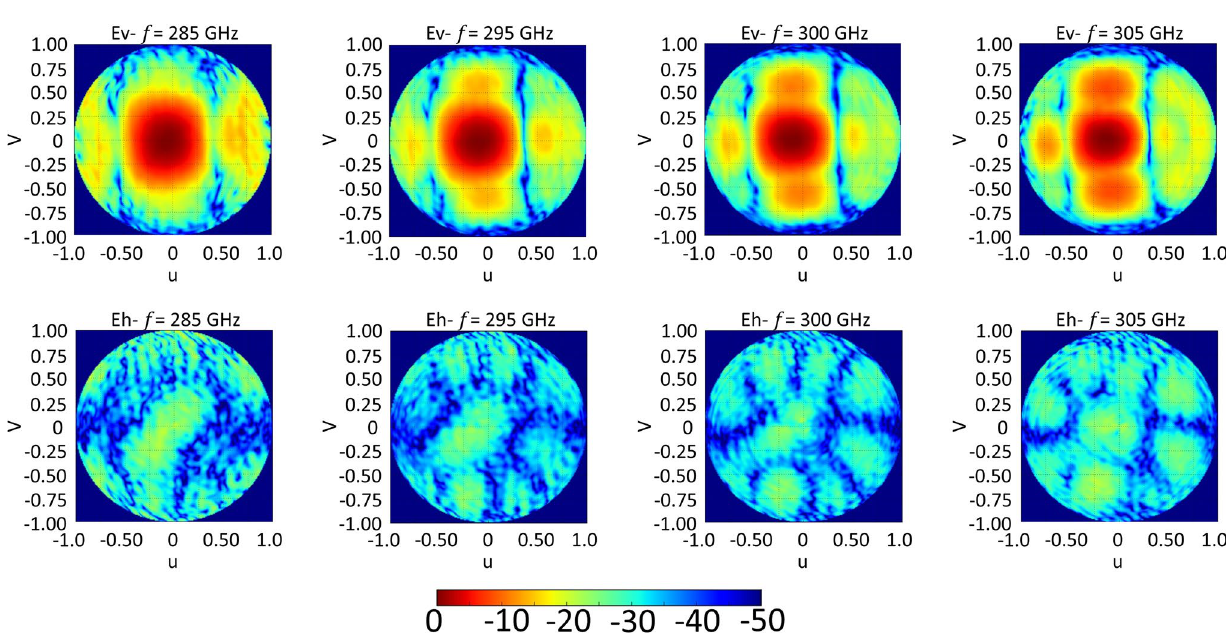
Figure 10. Measured 3D normalized radiation pattern of the proposed antenna (Co ‘Ev’ & Cross ‘Eh’— polarization components), in the u–v spectral plane at different frequencies. The color bar is on the dB scale.